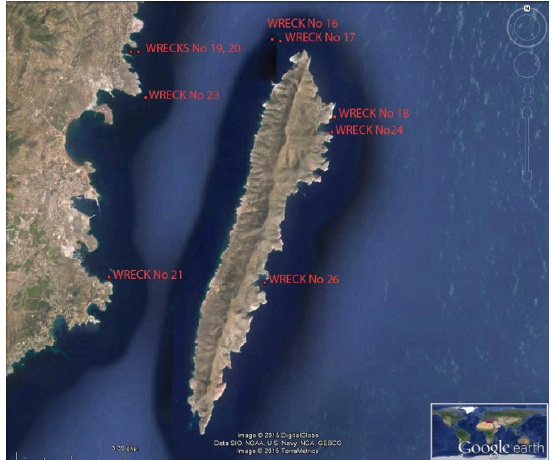
Figure 3:Locations of shipwrecks, Makronisos Island, ©